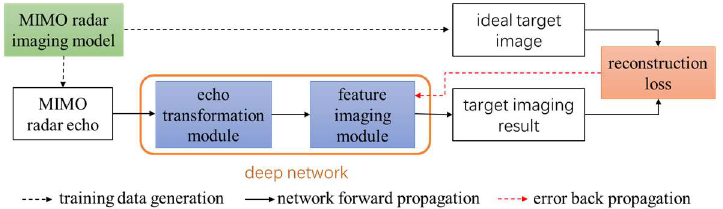
Figure 1. Non-orthogonal waveform MIMO radar imaging framework based on deep network.